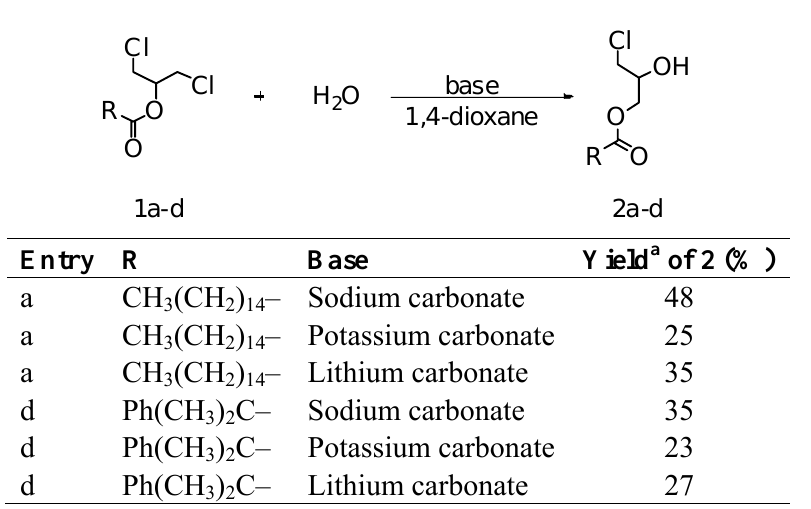
Table 2. Influence of different inorganic bases on 3-chloro-2-hydroxy-1-propyl ester formation in